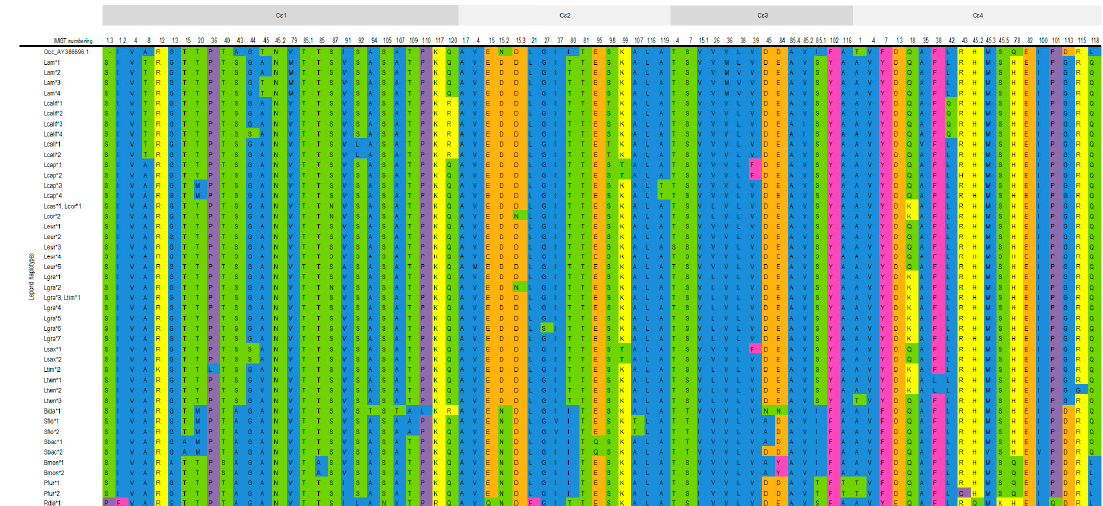
Figure 4. Variable codons and amino acid physicochemical properties for leporid IGHE constant domains. The codon numbering is according to the IMGT unique numbering for the constant domain (13). The colours represent amino acid properties: polar neutral (green), polar positive (yellow), polar negative (orange), non- polar neutral (purple), non-polar aliphatic (blue) and non-polar aromatic (light pink). Occ— Oryctolagus cuniculus cuniculus (accession number AY386696.1); Lcalif— Lepus californicus ; Lcall— Lepus callotis ; Lcas— Lepus castroviejoi ; Lcap— Lepus capensis; Leur— Lepus europaeus ; Lgra— Lepus granatensis ; Lsax— Lepus saxatilis; Ltwn— Lepus townsendi ; Lam— Lepus americanus; Lcap— Lepus capensis ; Ltim— Lepus timidus ; Pfur— Pentalagus furnessii ; Sflo— Sylvilagus floridanus ; Sbac— Sylvilagus bachmanii ; Rdia— Romerolagus diazii ; Bida— Brachylagus idahoensis ; Bmon— Bunolagus monticularis.